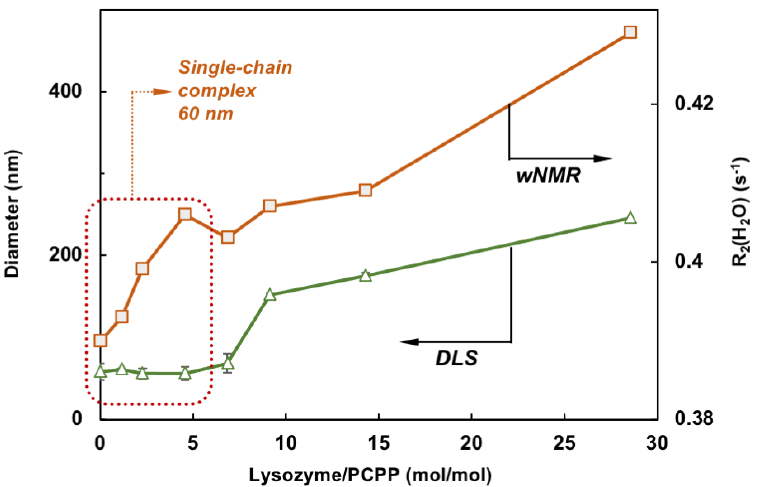
Figure 4. Comparison of w NMR and DLS data shows that contrary to DLS, w NMR is capable of detecting self-assembly processes at low lysozyme loadings (the zone for complexes formed with a single PCPP chain is designated by dotted line, z-average diameters are shown, mixing in equal volumes).